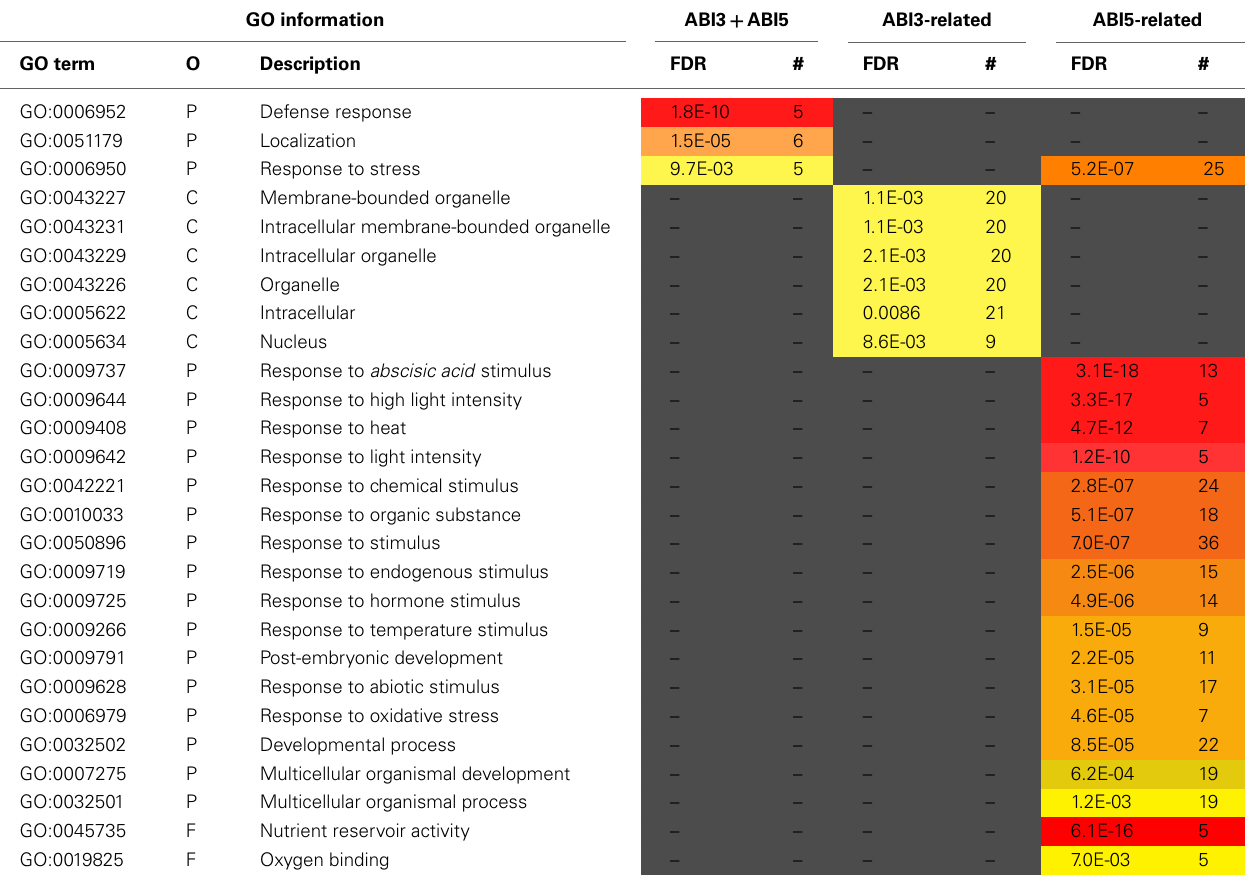
Table 3 | MtABI3 and MtABI5 are involved in complementary processes in relation to desiccation tolerance in Medicago truncatula . GO